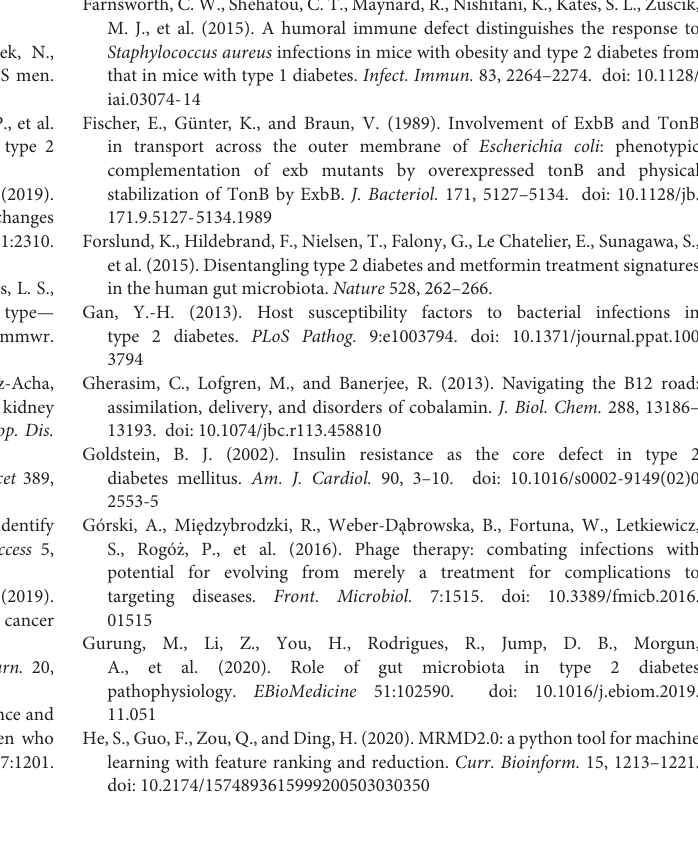
Supplementary Table 1 | Ranked eggNOG features by mRMR. Supplementary Table 2 | Ranked KO features by mRMR. Supplementary Table 3 | Performance of IFS for eggNOG features with an interval of 10. Supplementary Table 4 | Performance of IFS for KO features with an interval of 10. Supplementary Table 5 | Performance of IFS for NOG features with an interval of one. Supplementary Table 6 | Performance of IFS for KO features with an interval of